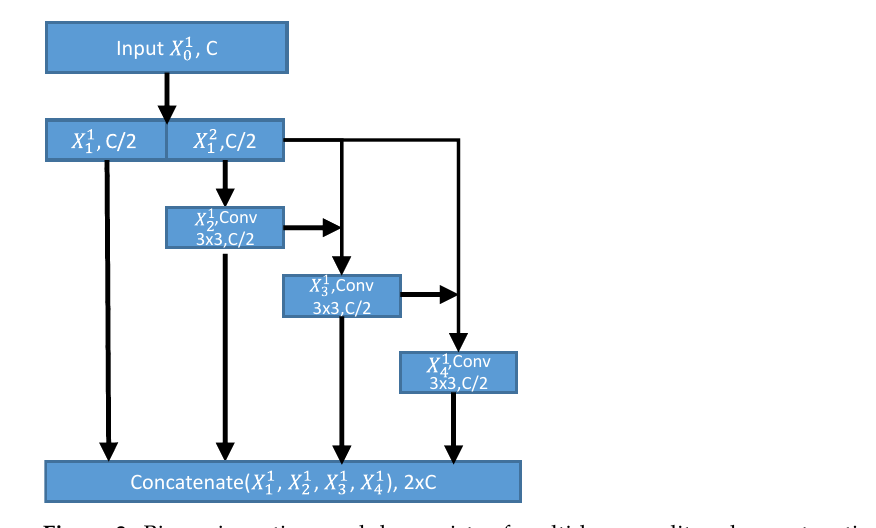
Figure 3. Binary inception module consists of multi-layers split and concatenation operations to enhance the generalization ability of the network.